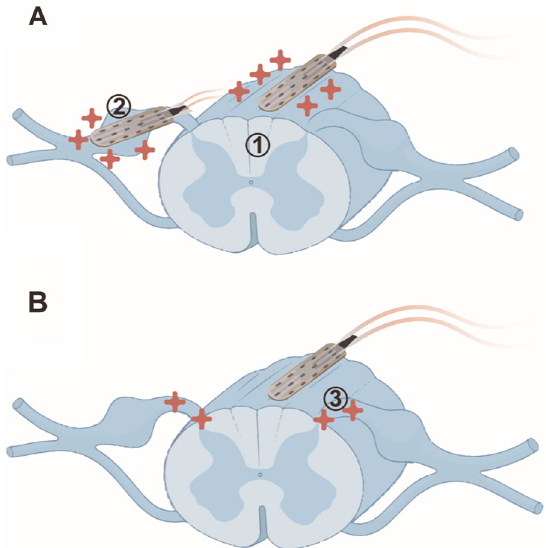
Fig. 1 Placement and stimulation target of ESCS. A In chronic pain applications electrodes are either positioned epidurally above the lemniscal tract (1) or the dorsal root ganglion (2) to target respective neuroanatomical structures. B In case recovery of motor and autonomic function are to be addressed, electrode arrays are placed epidurally above the lemniscal tract to target the posterior roots